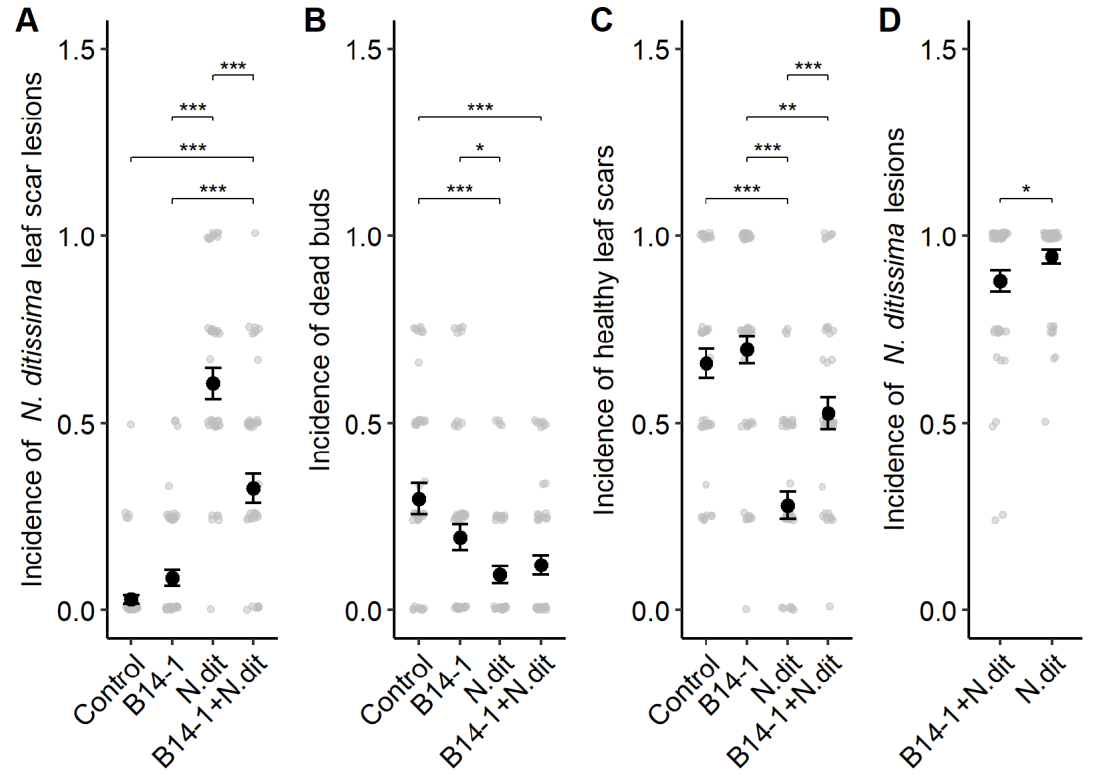
Figure 3. Antagonistic efficacy of B14-1 against N. ditissima in the field trial. Outcomes of the leaf scar protection ( A – C ) and pruning wound protection experiments ( D ) are shown (n = 48). Incidences of N. ditissima canker lesions ( A , D ), dead buds without a clear canker lesion ( B ) and of healthy leaf scars where adjacent buds produced healthy foliage ( C ) are presented. Treatments are shown along the horizontal axis, namely, control leaf scars (water) are shown alongside inoculated with B14-1 (B14-1), N. ditissima (N.dit) alone, or a combination of both (B14-1 + N.dit). Estimated marginal means ± 1 SE and raw data points (in grey, n = 48) are displayed. Statistical significance between the treatments is presented as: “*” (0.05 > p > 0.01), “**” (0.01 > p > 0.001) and “***” ( p < 0.001).